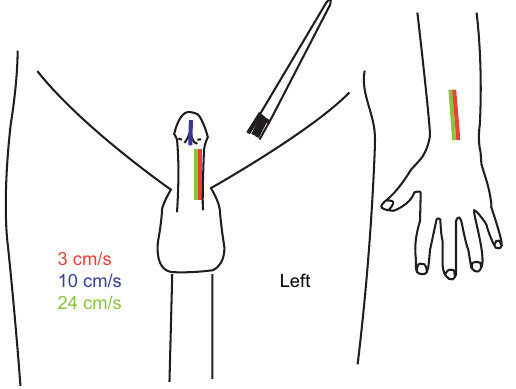
Figure 5. Overview of the various skin stimulation sites and corresponding velocities. The forearm and penile shaft were stimulated at velocities of approx. 3 and 24 cm/s, whereas the penile frenulum was only stimulated at approx. 10 cm/s. Figure was created using Adobe Illustrator 2022 for Mac (v. 26.2.1; https:// www. adobe. com/ produ cts/ illus trator.